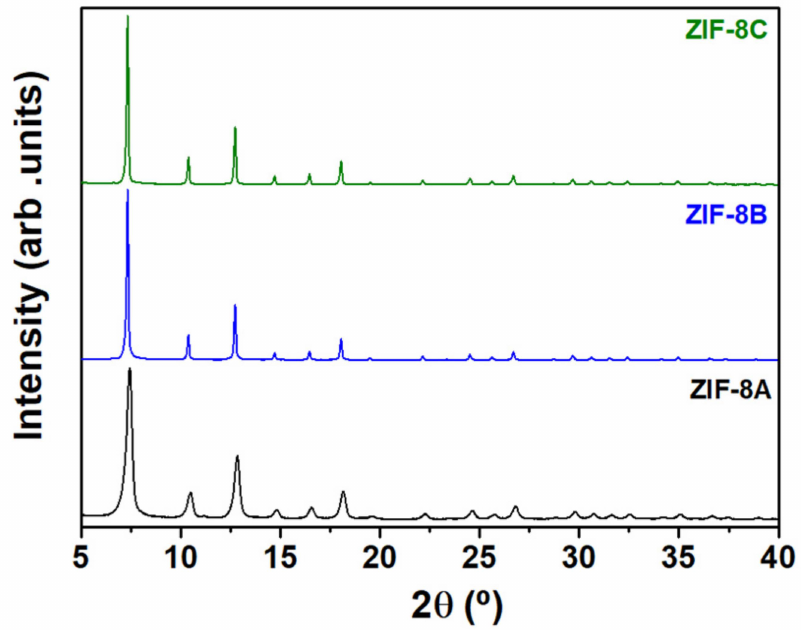
Figure 1. Room temperature XRD patterns of ZIF-8A (black), ZIF-8B (blue) and ZIF-8C (green). Profile fitting was used to index the XRD patterns on the cubic space group